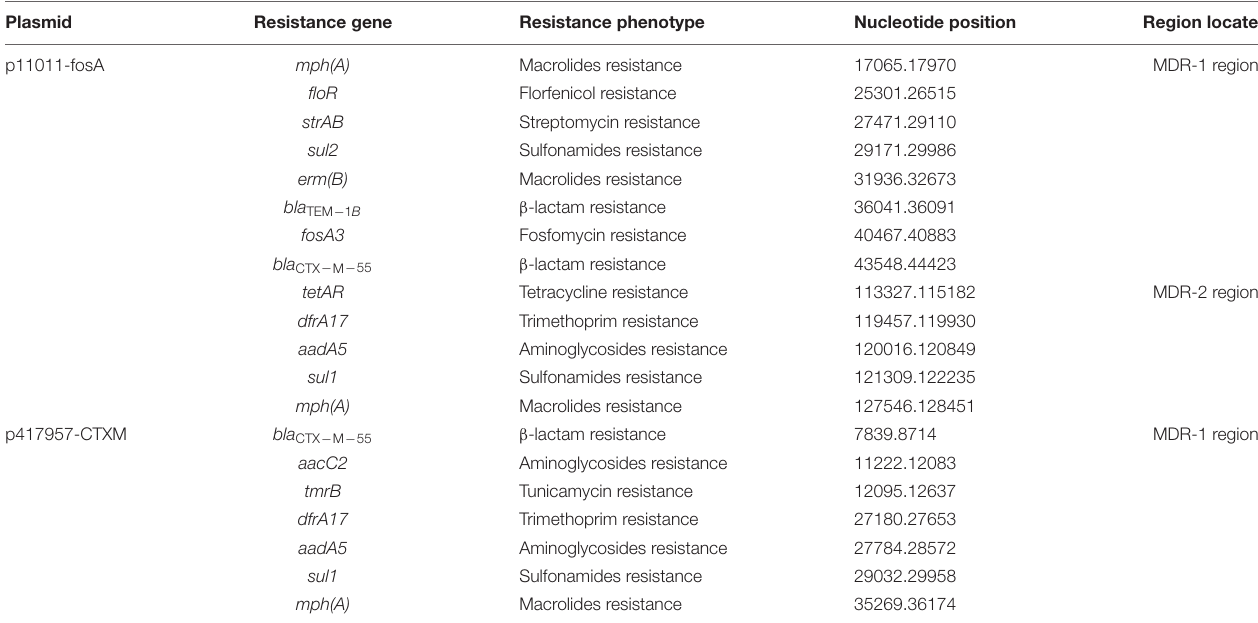
FIGURE 1 | The complete sequence diagram of p11011-fosA and p417957-CTXM. Note: In the figure, the innermost ring represents (G-C)/(G + C); the blue ring indicates GC content, and the outward depression indicates that the GC content is higher than the mean value. Black area in the outer circle represents the backbone area and gray area represents the accessory modules. The outermost circle shows the distribution of genes represented by colored arrows in the plasmid. TABLE 4 | Antibiotic resistance genes in sequenced plasmids. Plasmid Region